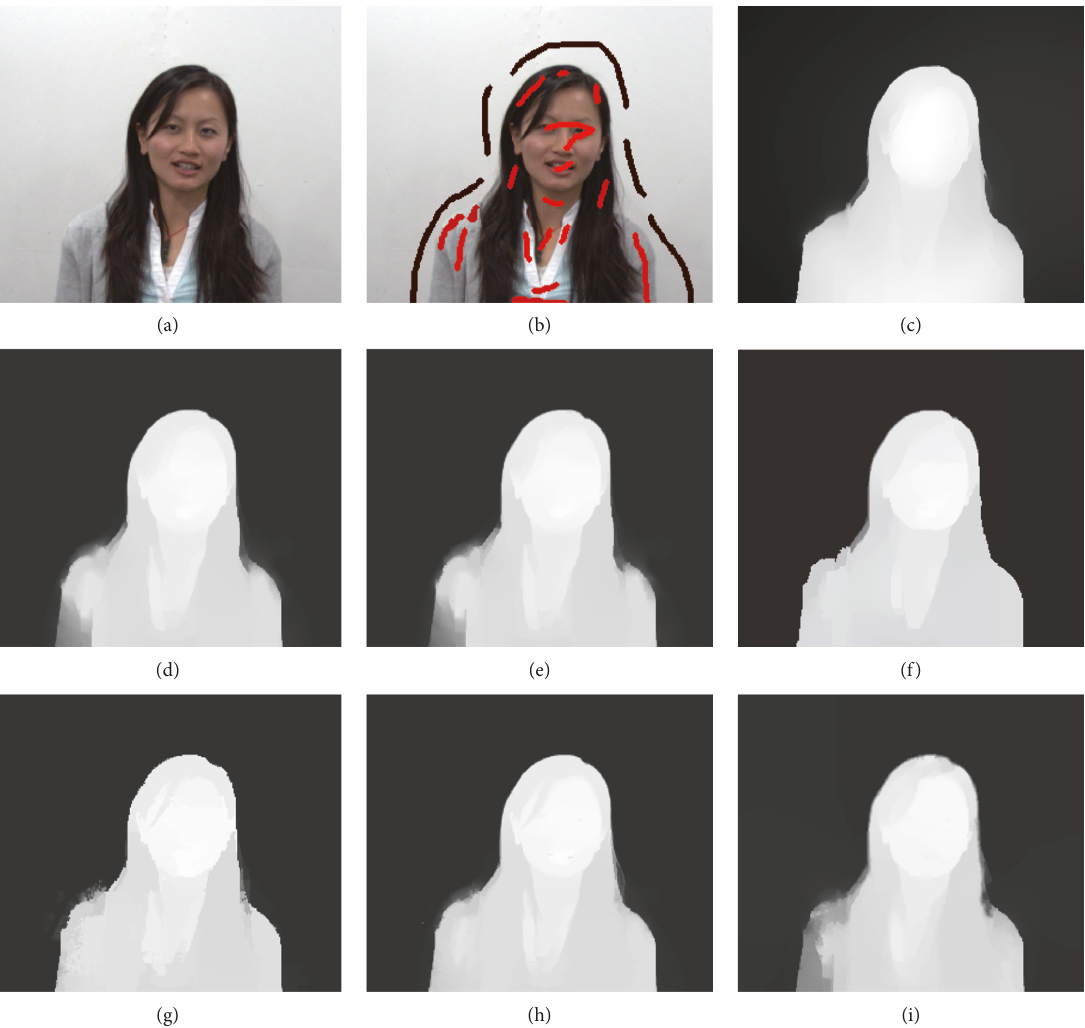
Figure 5: Results for RGBZ_03 in the absence of inaccurate scribbles. (a) Input image. (b) User scribbles. (c) Groundtruth. (d) Depth of